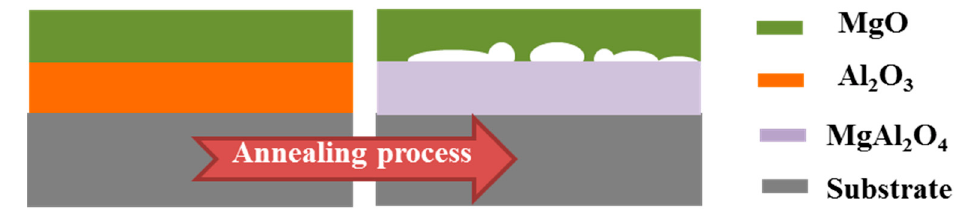
Figure 1. The synopsis illustrations of the Kirkendall effect at the interface of MgO and Al 2 O 3 .